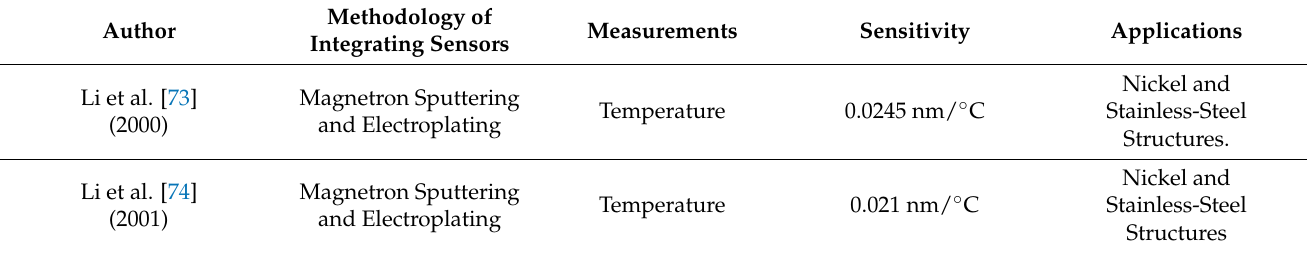
Table 4. Overview of applications and methodology of integrating Fibre Bragg grating sensors in metal structural